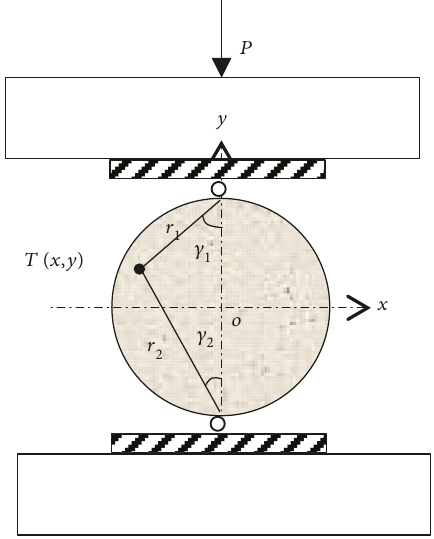
Figure 3: Forces acting on a point in the